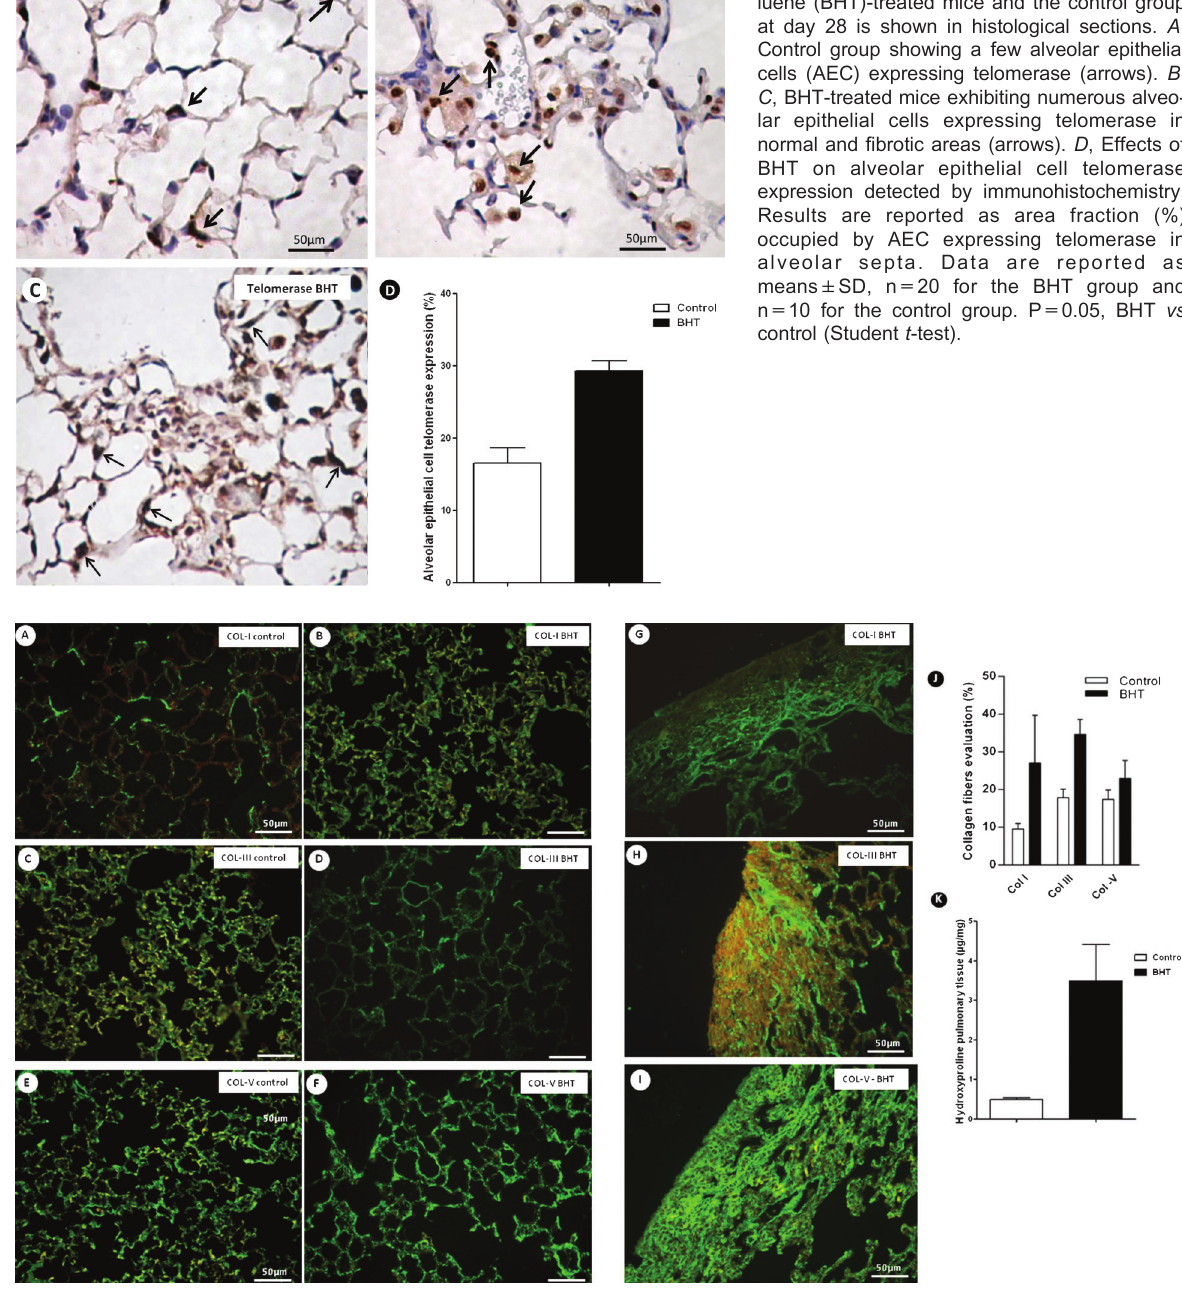
Figure 5. Type I, III, and V collagens from 3-5-di-tert-butyl-4-hydroxytoluene (BHT)-treated mice and the control group at day 28 are shown in histological sections. A , C , E , Control mice showing the normal collagen fibers of types I, III, and V in alveolar interstitium. B , D , F , BHT-treated mice exhibiting a strong green birefringence of collagens I, III, and V in alveolar interstitium of normal areas. G , H , I , BHT-treated mice exhibiting architectural distortion and a diffuse increase of collagens I, III, and V birefringence. J , K , Effects of BHT on collagen types and hydroxyproline detected by immunofluorescence and biochemistry, respectively. Results are reported as area fraction (%) occupied by collagen fibers and as m g/mg hydroxyproline in alveolar interstitum. Data are reported as means±SD, n=20 for the BHT group and n=10 for the control group. P=0.05, BHT vs control (Student t -test). Col: